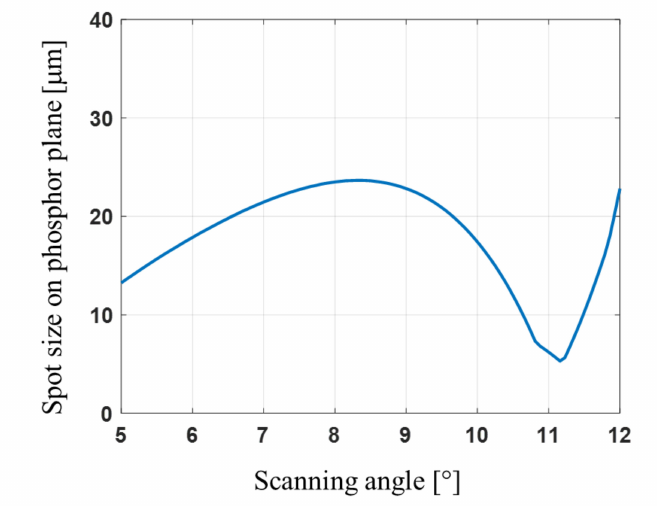
Figure 7. Change in spot size on phosphor plane according to scanning